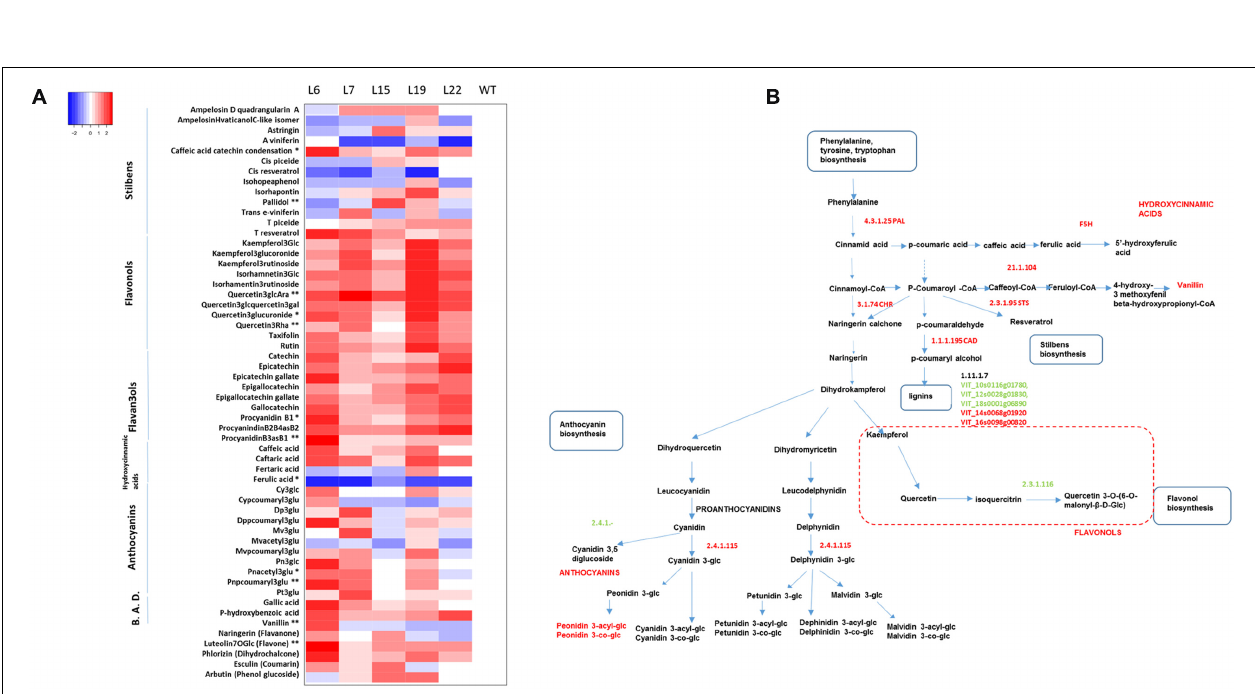
FIGURE 4 | RNA-Seq analysis of L15 line. (A) Classical multidimensional scaling showing the percentage of variance explicated by PC1 and PC2. (B) Volcano plot used for selection of differentially expressed genes (DEGs) between L15 and WT lines. Spots represent genes. The red line represents the significance threshold of p -value (0.05) and the blue lines represent log2 fold change values of 1.5 and − 1.5. Genes located above the red line and on the right-hand side or the left-hand side of blue lines were selected as DEGs.